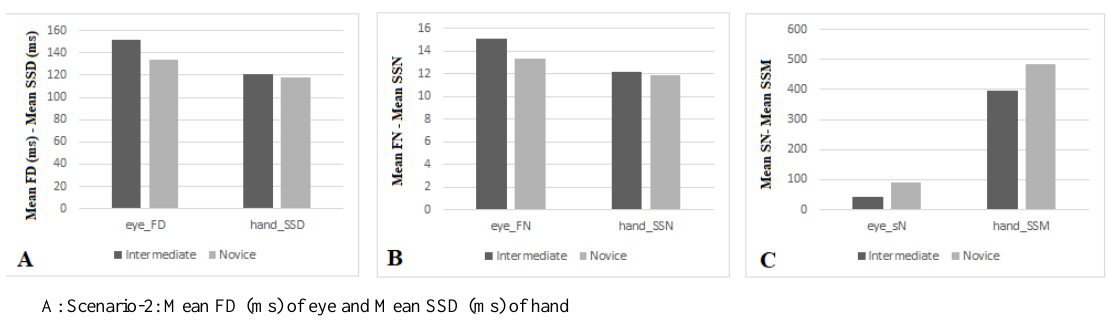
Figure 7. Mean for Eye and Hand Metrics for each group in Scenario-1